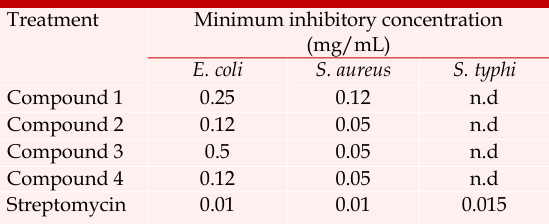
Antibacterial activity of isolated compounds